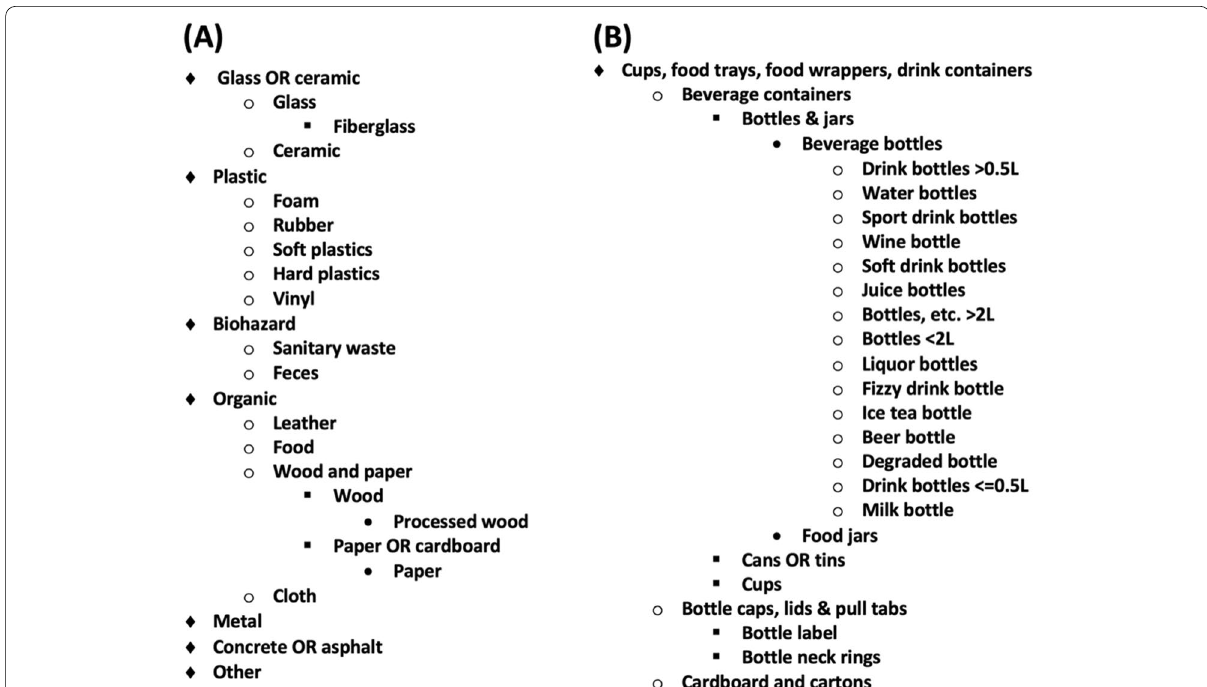
Fig. 3 A Tree diagram of materials hierarchy list displaying all hierarchical relationships among material words. At the far left of the tree is the most general classification and at the terminal end of each branch is the most specific classification. For example, soft plastic is a terminal end of the hierarchy in the materials hierarchy and a subclass of plastic . B A subset of the tree diagram of items hierarchy list. The entire hierarchy can be seen online at openanalysis.org/trashtaxonomy. At the far left of the tree is the most general classification and at the terminal end of each branch is the most specific classification. For example, cups, food trays, food wrappers, and drink container s are a higher classification order, while wine bottle is a more specific subclass. Arrows pointing right have additional subclasses and can be